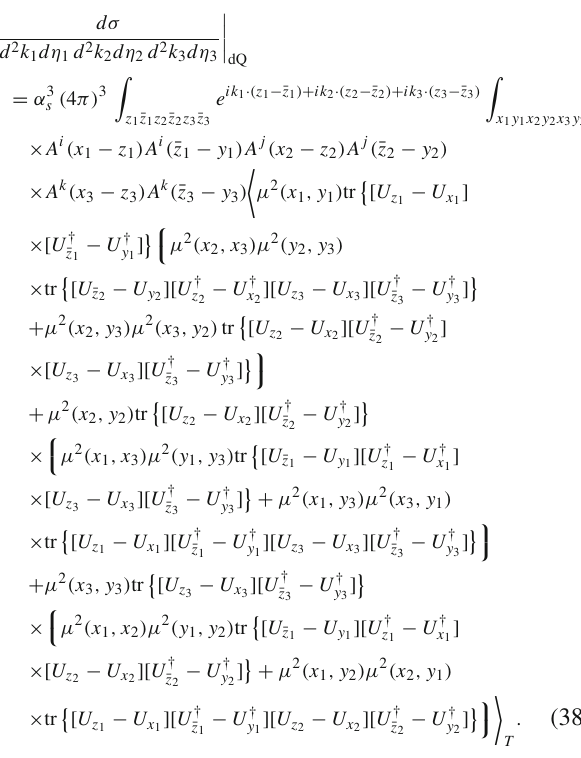
write the dipole-quadrupole contribution to the three-gluon